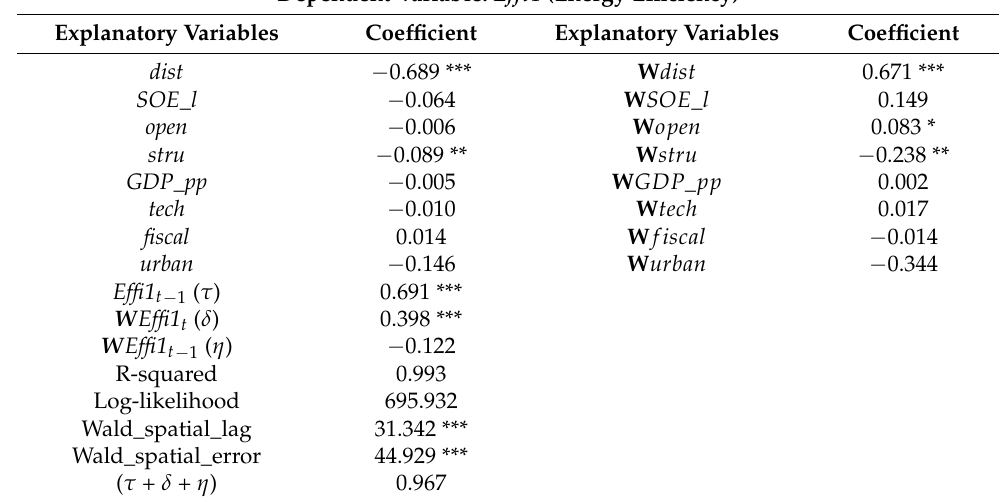
Table A1. Robustness test. Dependent Variable: Effi 1 (Energy